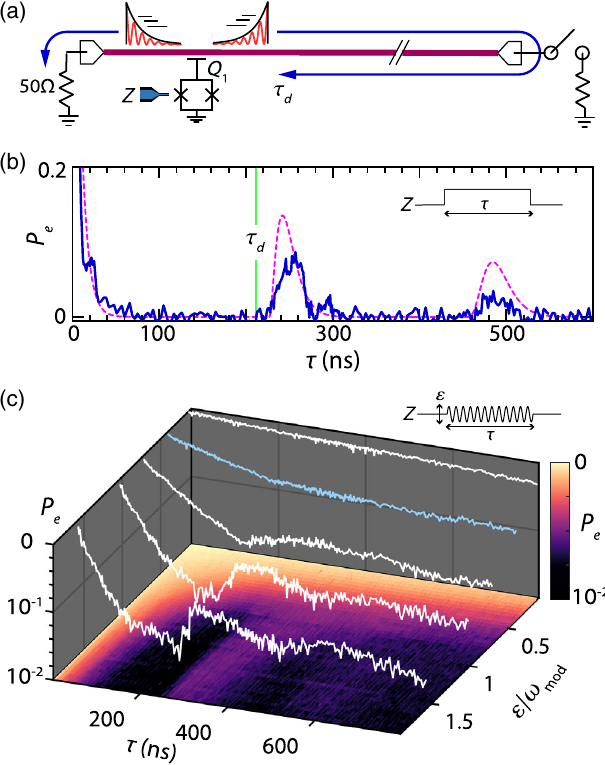
FIG. 4. Time-delayed feedback from a slow-light reservoir with a reflective boundary. (a) Illustration of the experiment, showing the qubit coupled to the metamaterial waveguide which is terminated on one end with a reflective boundary via a microwave switch. (b) Measured population dynamics of the excited state of the qubit when coupled to the metamaterial waveguide terminated in a reflective boundary. Here, the bare qubit is tuned into the middle of the passband. The onset of the population revival occurs at τ ¼ 227 ns, consistent with round-trip group delay ð τ d Þ measurements at that frequency, while the emission lifetime of − 1 ¼ 7 . 5 ns. The magenta curve is a theoretical the qubit is ð Γ 1 D Þ prediction for emission of a qubit into a dispersionless, lossless semi-infinite waveguide with equivalent τ and Γ 1 (see Appen- d D dix G for details). (c) Population dynamics under parametric flux modulation of the qubit, for varying modulation amplitudes, demonstrating a Markovian to non-Markovian transition. When the modulation index ( ϵ = ω ) is approximately 0.4, we have mod Γ ϵ Þ ¼ 1 = τ ; the corresponding dynamical trace is colored 1 D ð d in